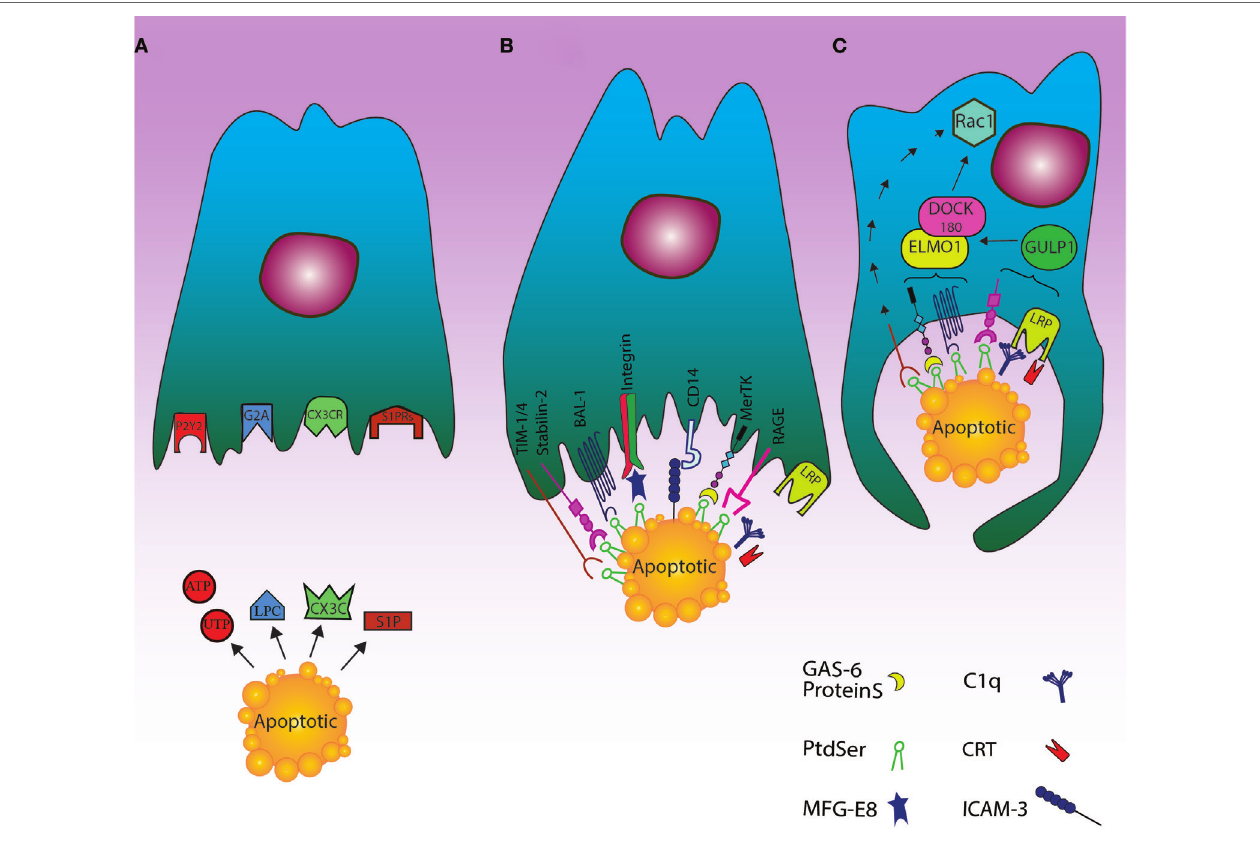
FigURe 1 | Cell death clearance processing by phagocytes through finding apoptotic cells, recognition their signals and engulfment of the cell corpses. (A) The “find me” signal: the dying cells release signals such as UTP, ATP, sphingosine-1-phosphate (S1P), and lysophosphatidylcholine or fractalkine through apoptosis. These “find me” signals can also conduct phagocytes to the location of cell death. Phagocytes can thus sense the “find me” signal to detect apoptotic cells using cognate receptors including sphingosine-1-phosphate receptor (S1PRs), purinergic receptors (P2Y2), G-protein-coupled receptor (G2A), and CXCR3. (B) The “eat me” signal: the dying cells expose “eat me” signals on their surface, so phagocytes can recognize and engulf apoptotic cells by recruiting a complex of receptors and bridging molecules. The main common “eat me” signals include the expression of phosphatidylserine (PS) on the outer layer of plasma membrane, brain- specific angiogenesis inhibitor 1, T cell immunoglobulin mucin receptor (TIM1, TIM3, TIM4), RAGE, and stabilin along with PS-specific bridging molecules, Gas6, Milk Fat Globule EGF Factor 8 (MFG-E8), and protein S. Other “eat me” signals include calreticulin (CRT) and ICAM3, which can modulate the identification and engulfment of apoptotic cells by LRP receptors ( via C1q) and CD14, respectively. (C) The engulfment process: after recruitment of engulfment receptors through the activity of Rac pathway, the polymerization of actin and rearranging of cytoskeletal are initiated. Although the mechanism of TIM4 in this process is unknown, some engulfment receptors recruit the DOCK180/ELMO1 set ( α v β 3, TAM, stabilin-2, and LRP). Thus, disorders during this step can lead to autoimmunity and